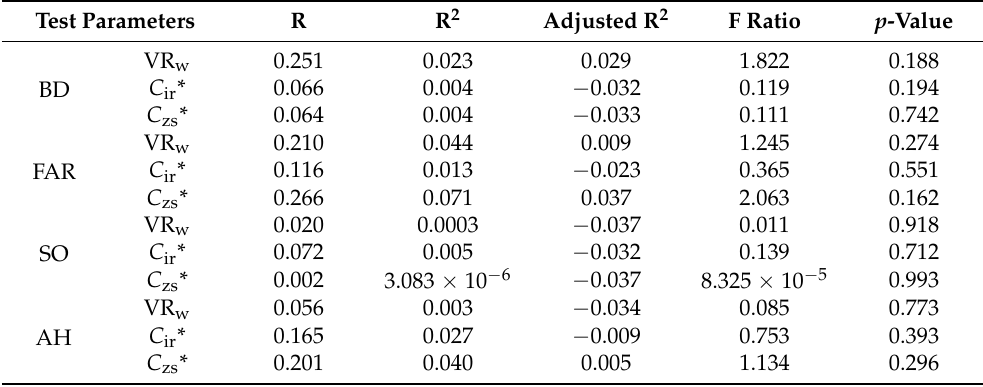
Table 4. Analysis of morphological variables, VR w , C ir * and C zs